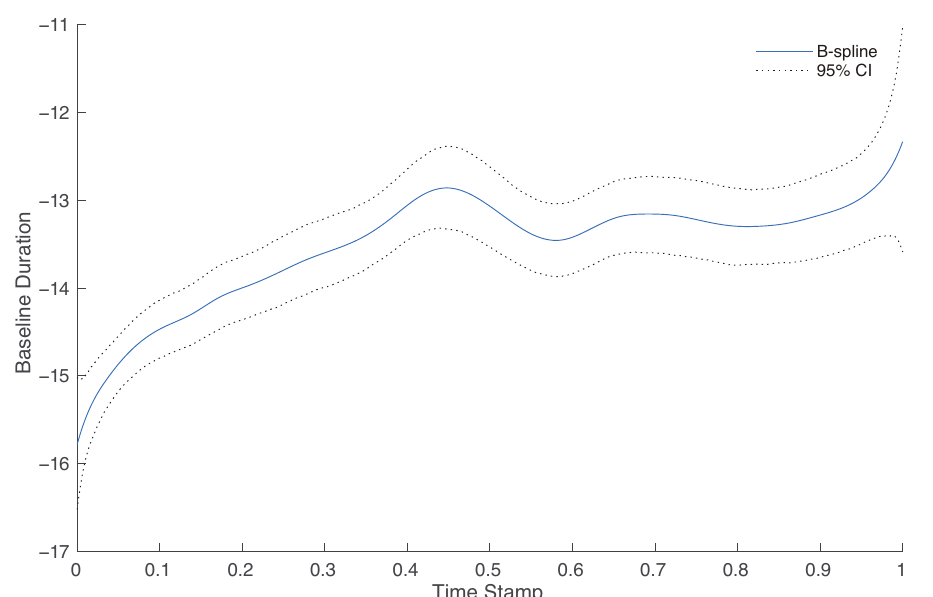
Figure 3. Intraday seasonality of time interval of TMC, Aichi, Japan (27 July 2016). Tables 11–16 show the DIC for each setting of AGH on 4 January 2016, 23 June 2016 and